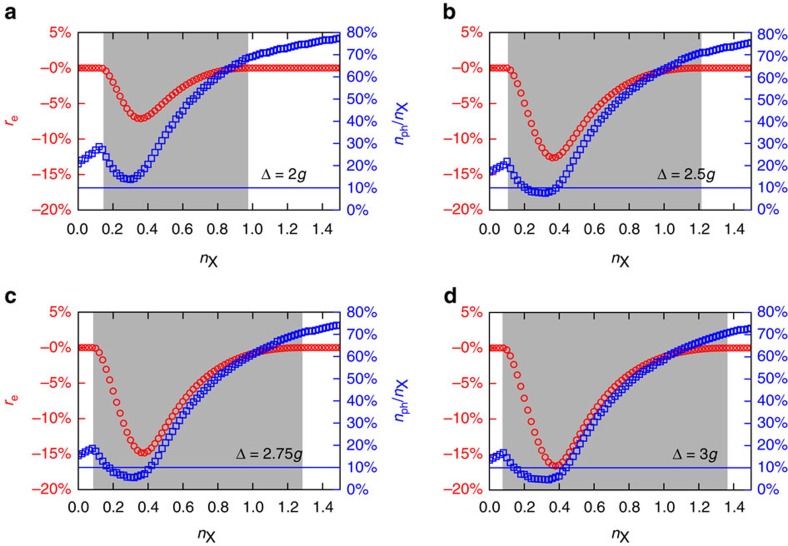
Energetics and photon densities in the modulated phase.Data denoted by red circles represent the quantity re in equation (33) plotted as a function of nX. Data denoted by blue squares represent the ratio between the photon density nph and the density nX of total excitations, as a function of nX and for the modulated phase only. Data in this figure have been obtained by setting the dielectric constant at κr=5 and the highest occupied LL at M=1. Above the horizontal blue line, nph/nX>10%. Different panels refer to different values of the ratio Δ/g: (a) Δ/g=2; (b) 2.5; (c) 2.75; and (d) 3.